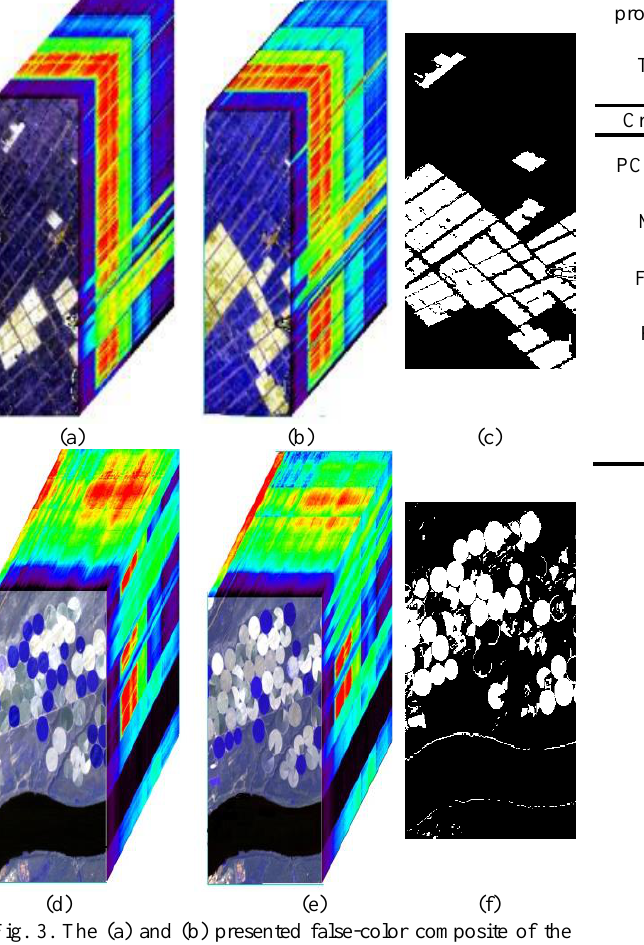
Fig. 3. The (a) and (b) presented false-color composite of the original hyperspectral images acquired in 2006 and 2007 of the China dataset respectively and (c) is related binary ground truth.